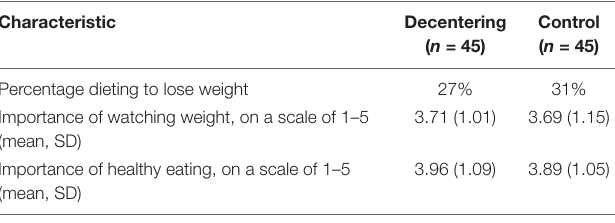
TABLE 1 | Participant characteristics in the two conditions.